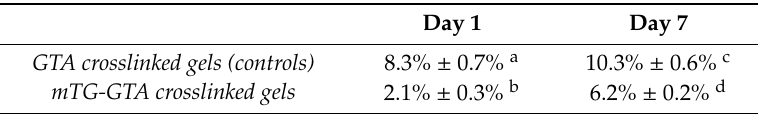
Table 2. Gel degradation expressed as the percentage of protein content in the supernatant with respect to the initial protein content.